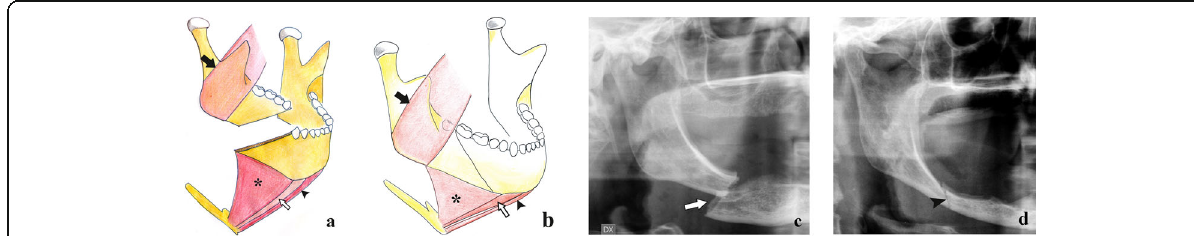
Fig. 4 Horizontal branch fractures. a Unfavourable fracture. Picture showing a fracture with a downward and posterior direction. The bone fragments are misaligned by the action of the masseter muscle (black arrow) that pulls the distal bone fragment upwards, and the mylohyoid (asterisk), geniohyoid (white arrow), and anterior belly of digastric (black arrowhead) muscles that pull the mesial bone fragment downwards. b Favourable fracture. Picture showing a fracture with a downward and anterior direction. The bone fragments impact each other with no displacement. c , d Cropped panoramic radiographs in toothless patients with unfavourable (arrow) and favourable (arrowhead) horizontal branch